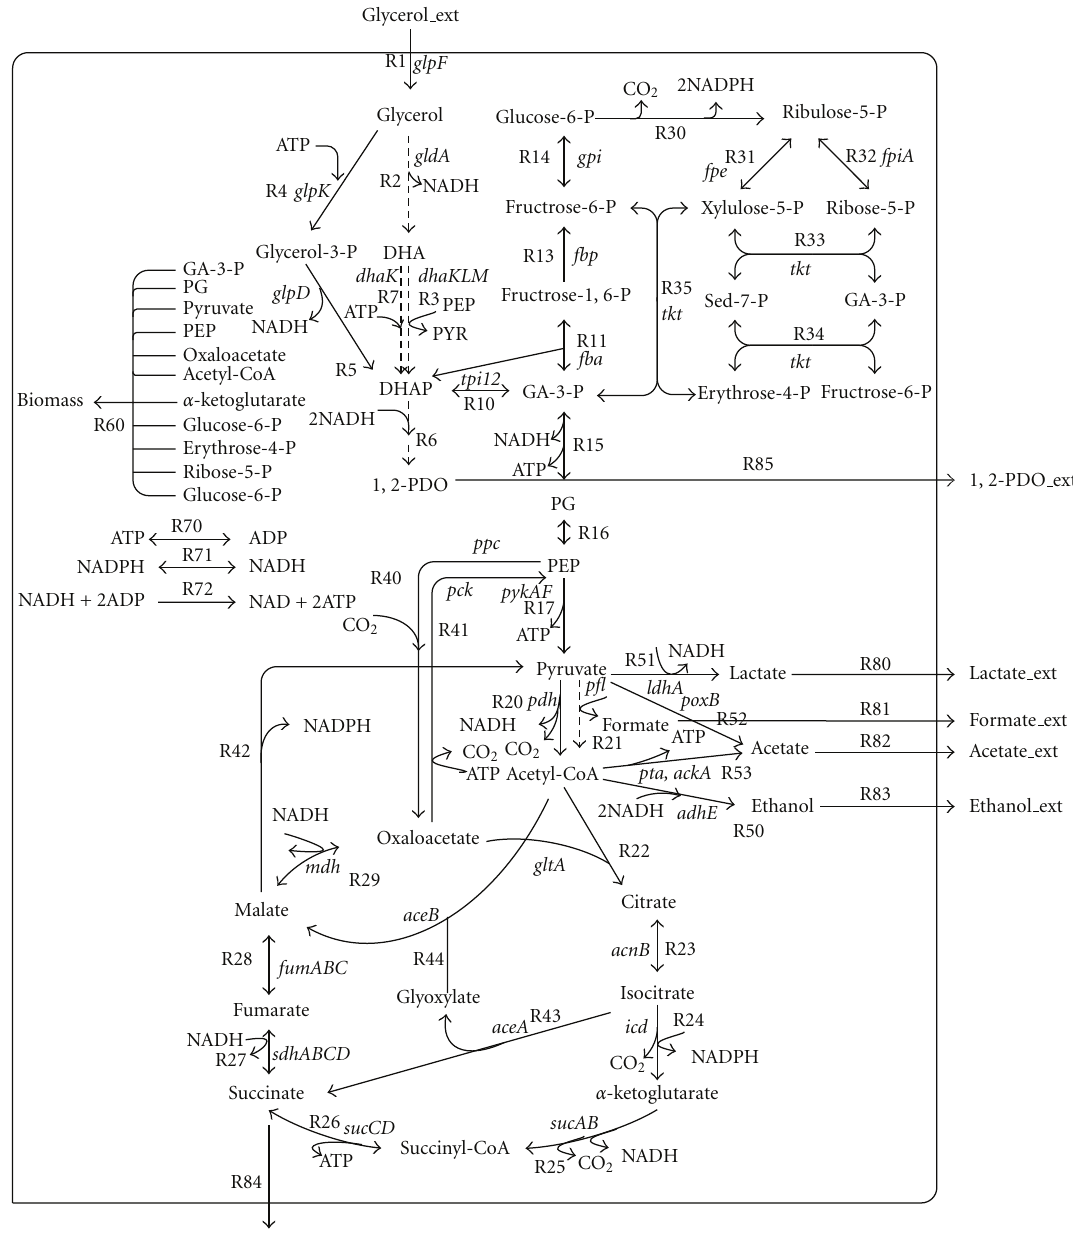
using external electron acceptors. In this pathway, glycerol